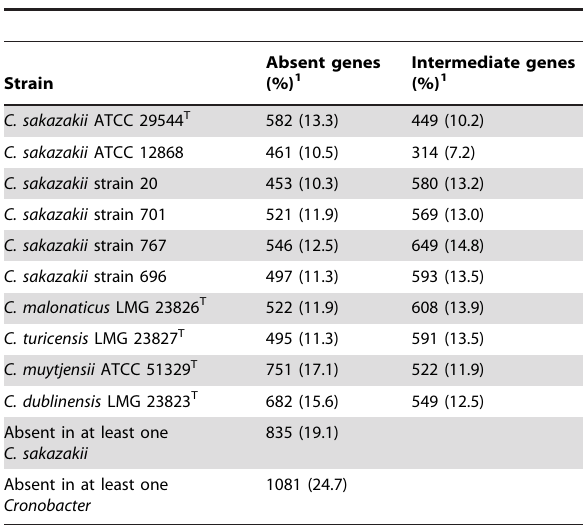
Table 2. Number of absent or divergent and intermediate genes in Cronobacter strains when compared to the sequenced C. sakazakii